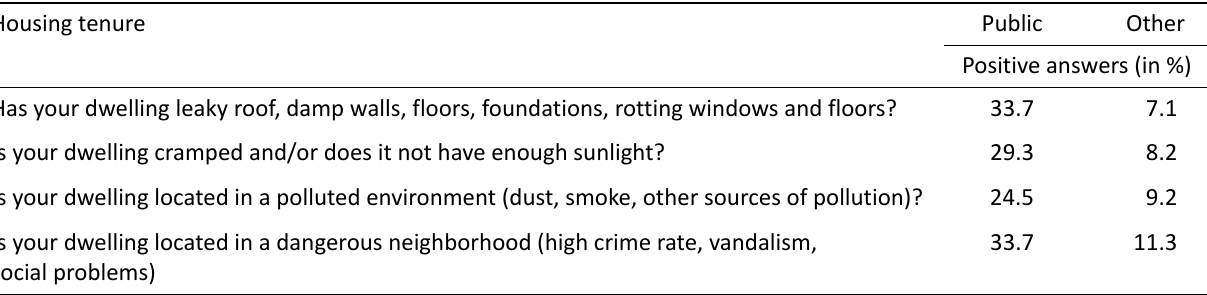
Table 5. Self-evaluation of living conditions, Lodz, 2011–2013. Housing